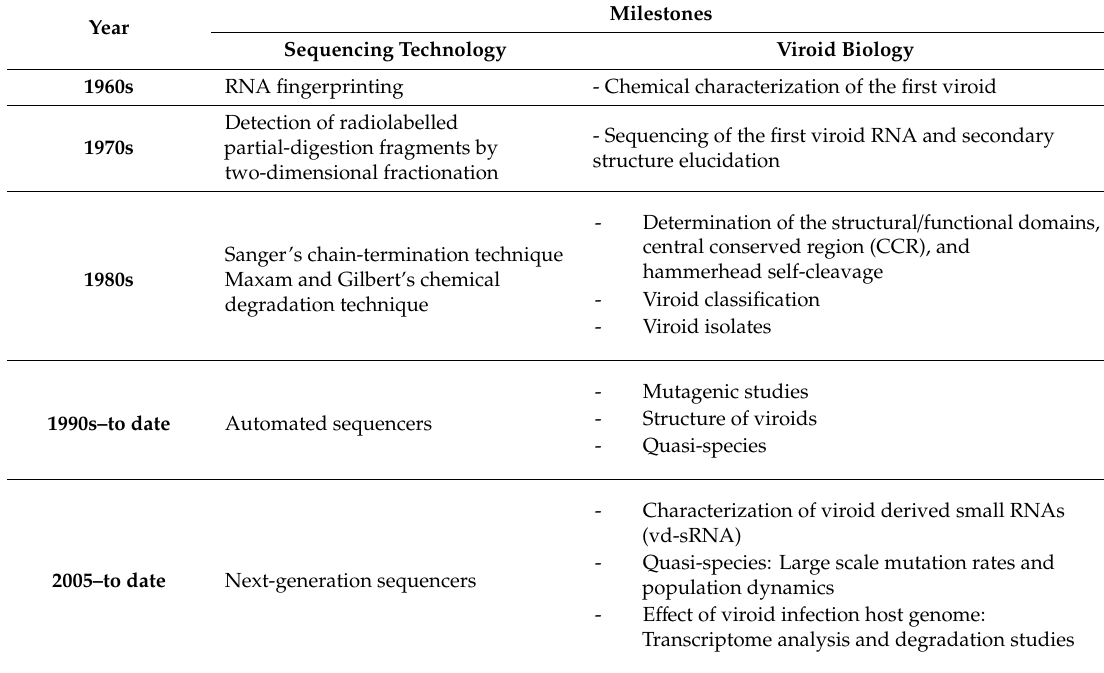
Table 1. Developments in sequencing technologies and their impact on viroid